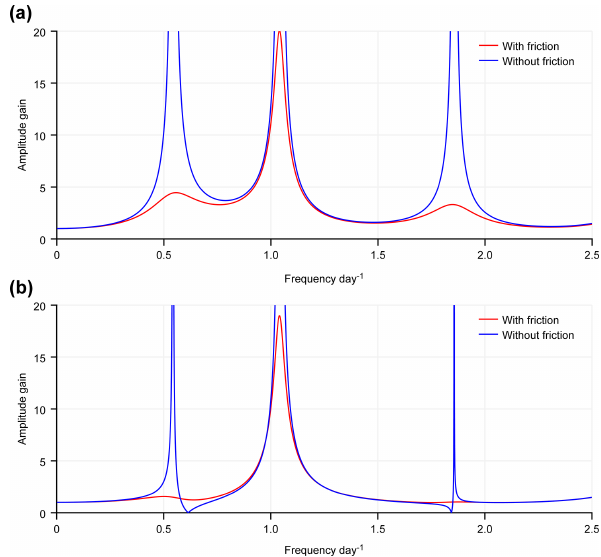
Figure 6. Response function at the locations x = − L 2 (a) and x = 0 (b) with and without